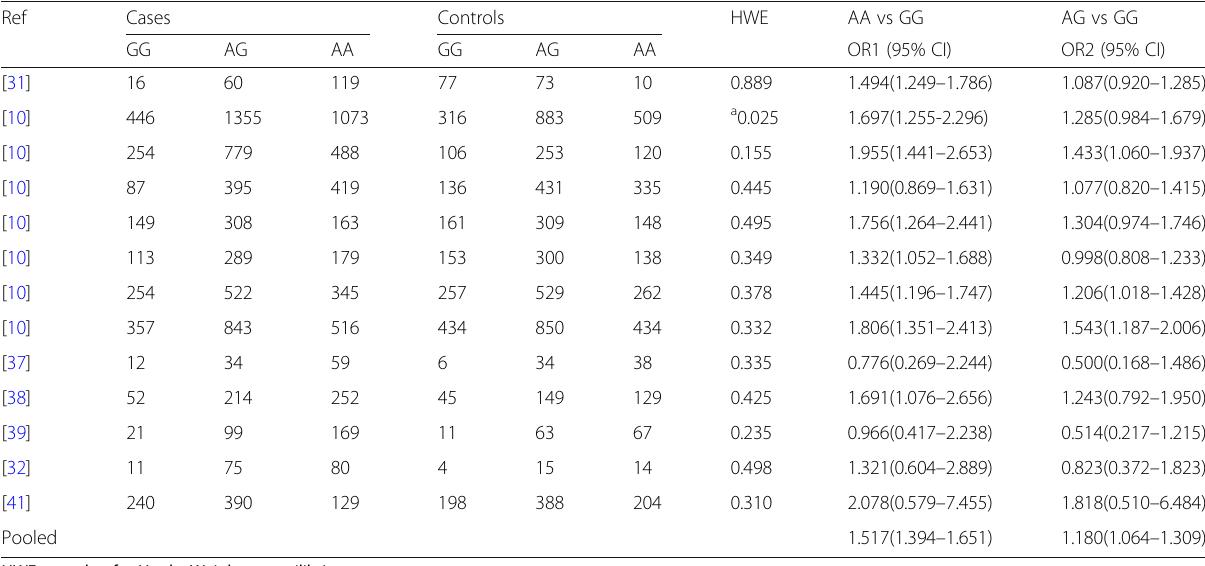
Table 2 The association between the HNF1B rs4430796 and prostate cancer (genotype distribution of case-control studies included in a